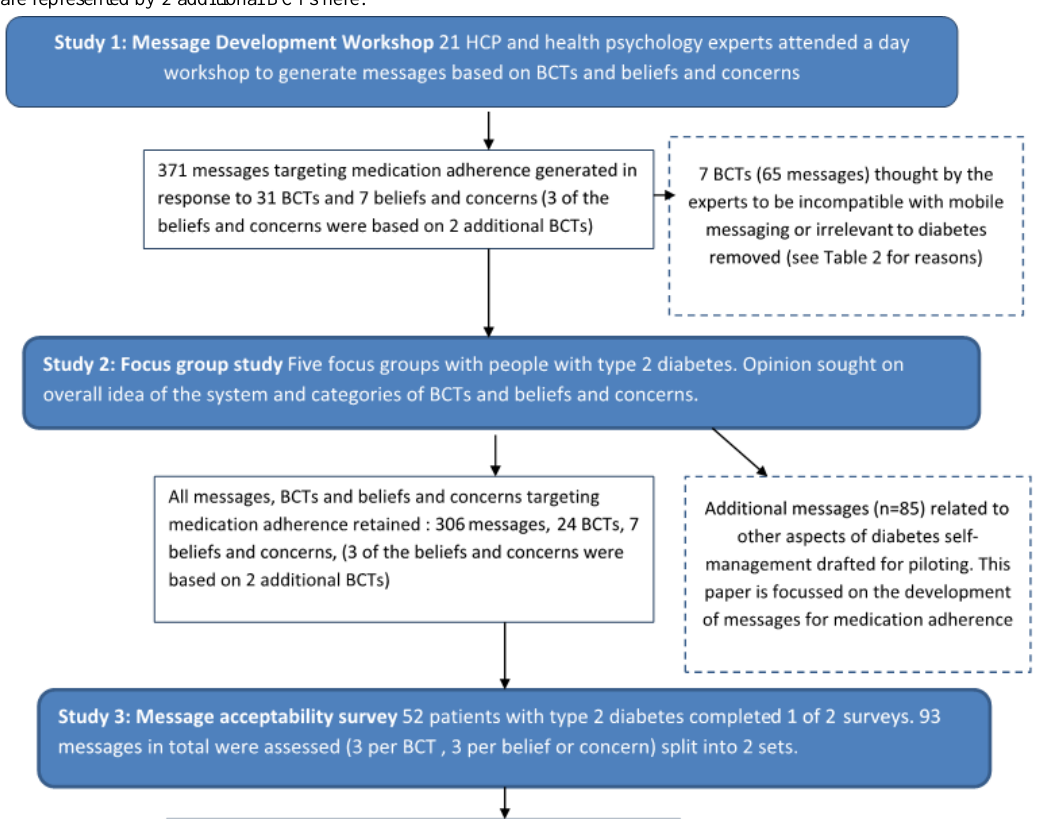
Figure 1. Development of messages targeting medication adherence through the four studies. BCT: behavior change technique; 1 Three of the beliefs and concerns are represented by 2 additional BCTs